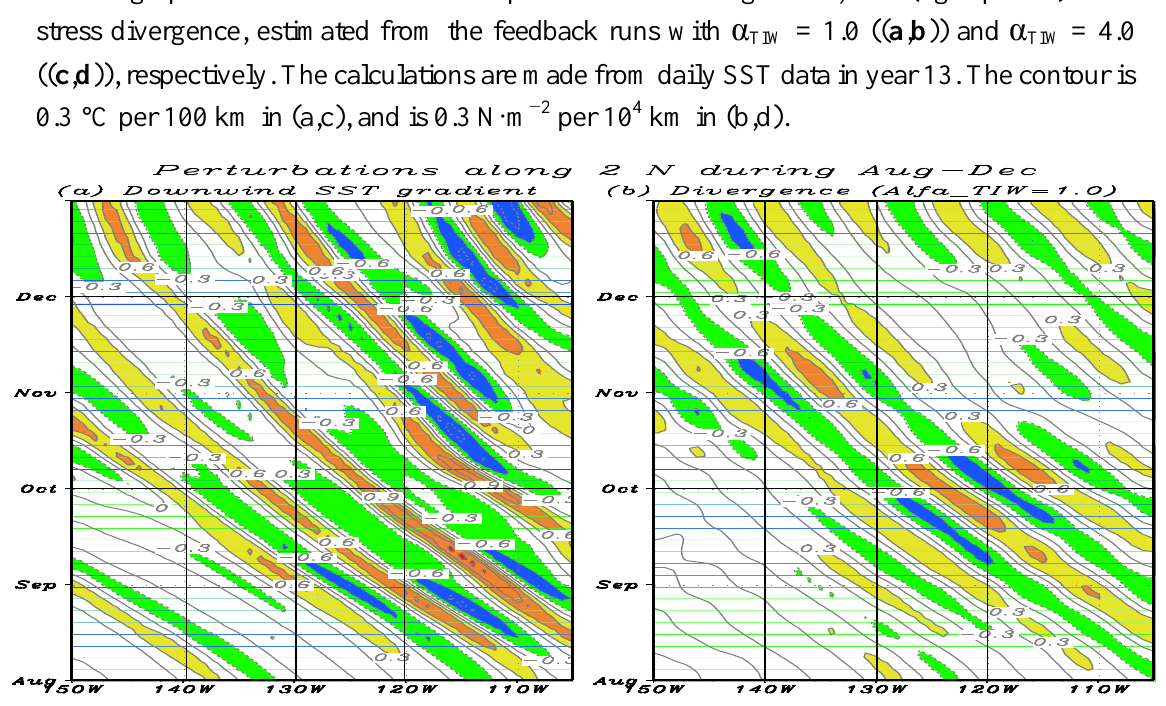
= 1.0 (( a , b )) and α = 4.0 TIW TIW